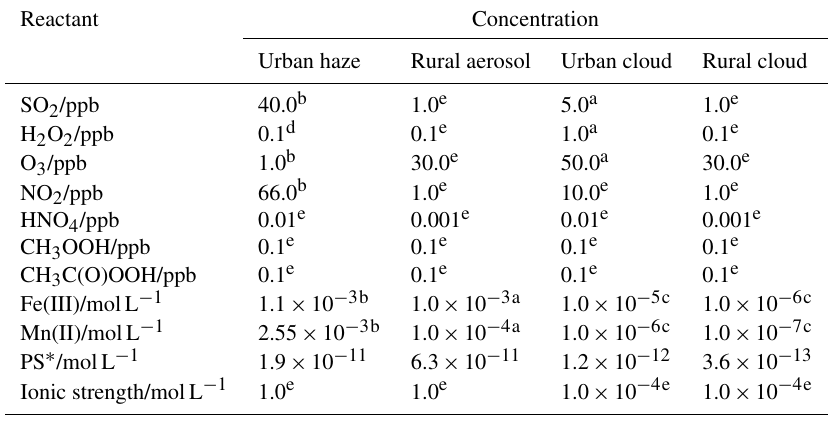
Table 1. Composition conditions applied for the calculation of the S(IV) oxidation rates of different reaction pathways for urban haze and rural aerosol conditions, as well as urban and rural cloud conditions (bottom) at